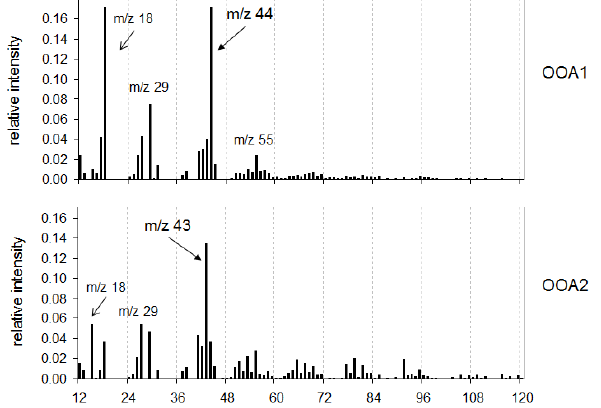
Fig. 6. OOA1 and OOA2 mass spectra (Q-AMS).